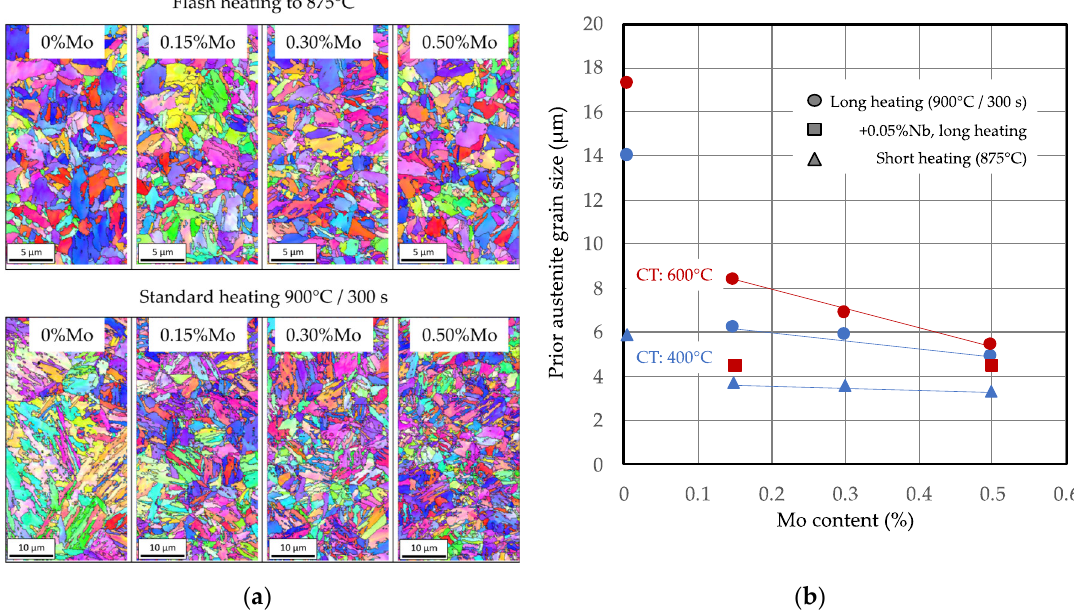
Figure 6. ( a ) Electron back scattering diffraction inverse pole figure micrographs of heat-treated steels (CT: 400°C) after quenching; ( b ) average prior austenite grain size of the various alloys and processing conditions.